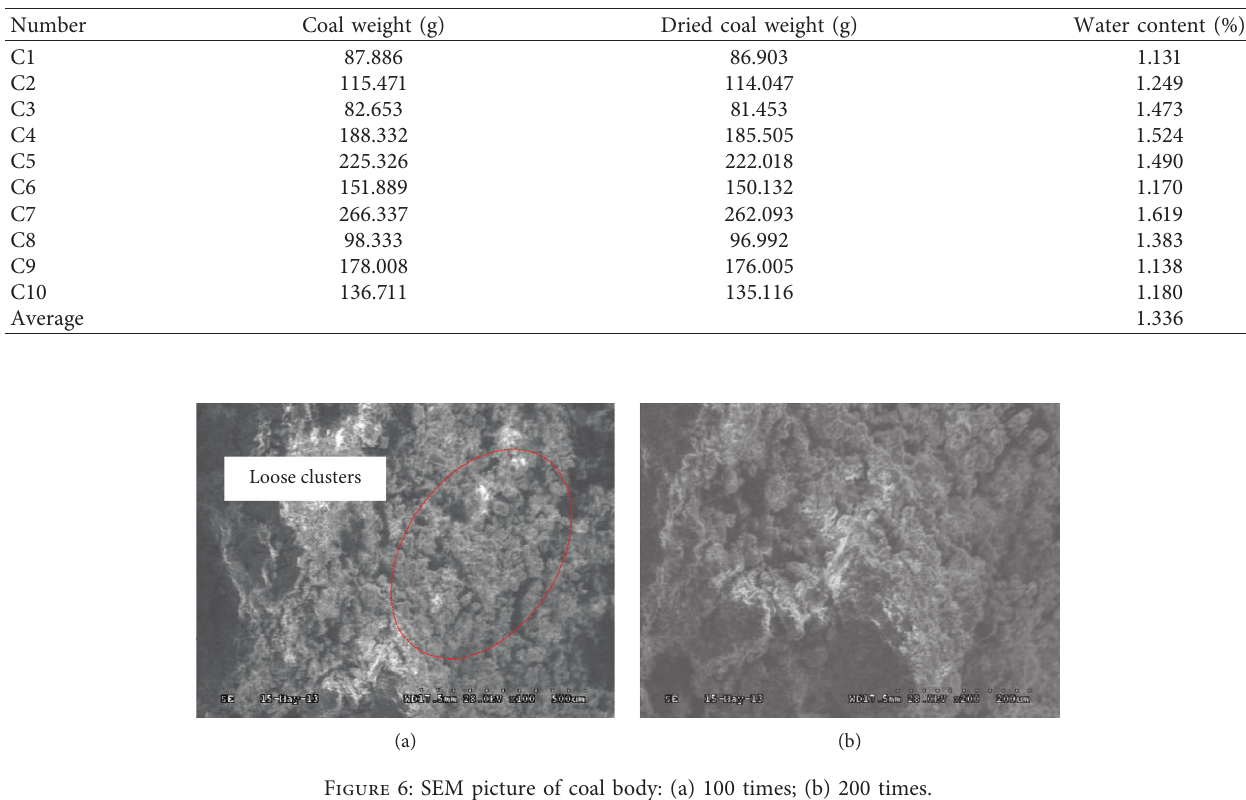
Table 3: Water content of raw coal.